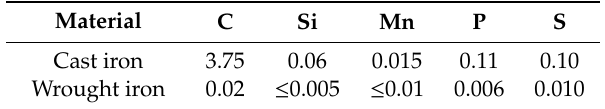
Table 1. Chemical composition of the material for experiments (wt.%).